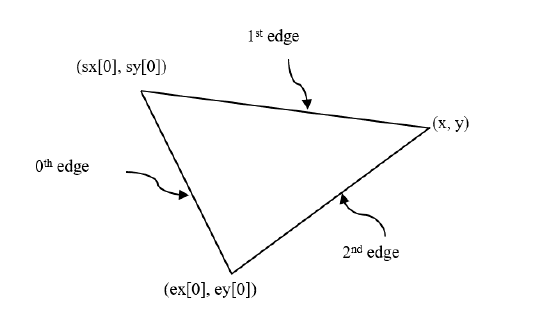
Figure 1: The primary hull.